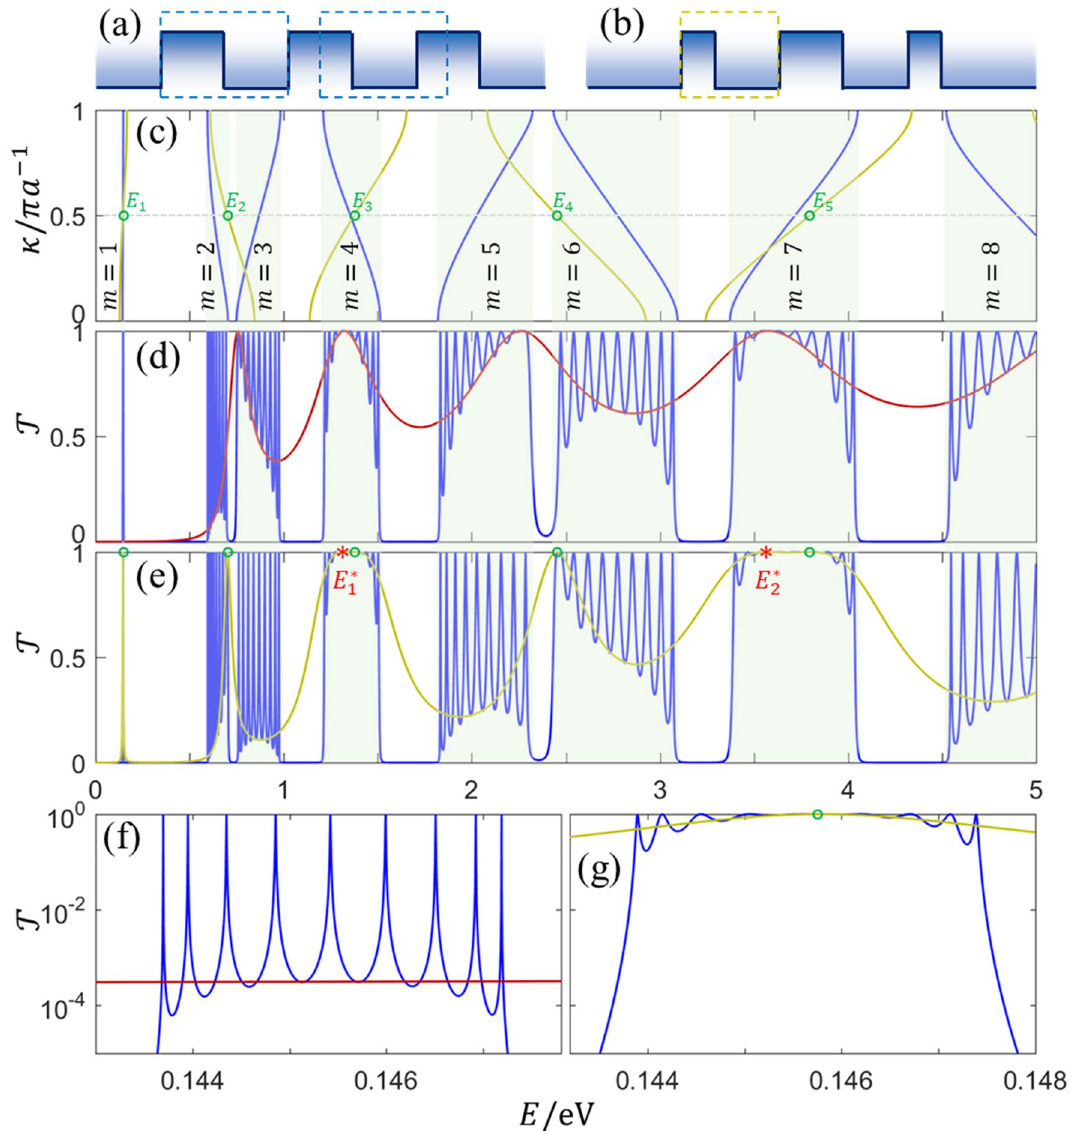
Figure 3. ( a ) The potential profile of periodic InP/InAs superlattice, dashed boxes mark the unit cells. ( b ) The potential profile of 2-period symmetric InP/InAs/InP structure. ( c ) Band structures of periodic InP/InAs 5 nm (blue line) and d b 2.5 nm (doderblue line), infinite superlattices when the InP barrier width is 2 d b = = respectively. ( d ) Transmission spectra for the 10-period InP/InAs superlattice (blue line) and for the single- barrier structure (red line), and barrier width is 2 d b . ( e ) Transmission spectra for 10-period superlattice with the unit cell of the symmetric InP/InAs/InP structure (blue line) and for the symmetric InP/InAs/InP structure only (doderblue line), and barrier width is d b . ( f ) and ( g ) are enlargements of ( d ) and ( e ), respectively. All well widths 5 nm. Circles and stars mark peaks in transmission are d w = region here) for two different superlattices, which are close to the transmission probabilities of the unit cell itself, especially around the symmetric resonances. The empirical explanation of the improvement might be the inde- pendent transmission of three different modes during coupling. At the first Brillouin zone, the coupling of Bloch modes and symmetric modes dominates the transmission due to the perfectly coherent resonance. By carefully choosing barrier and well widths, the perfectly coherent resonance energies of the local modes ( E ∗ n and 1,2,3, = ··· E n